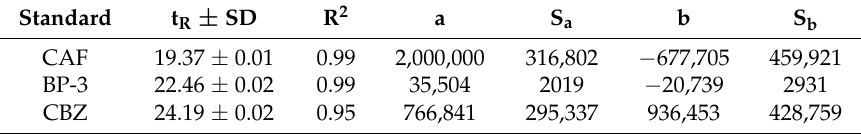
Table 3. Parameters of calibration curves for determining micropollutants by gas chromatography-mass spectrometry (GC-MS). chromatography-mass spectrometry (GC-MS).